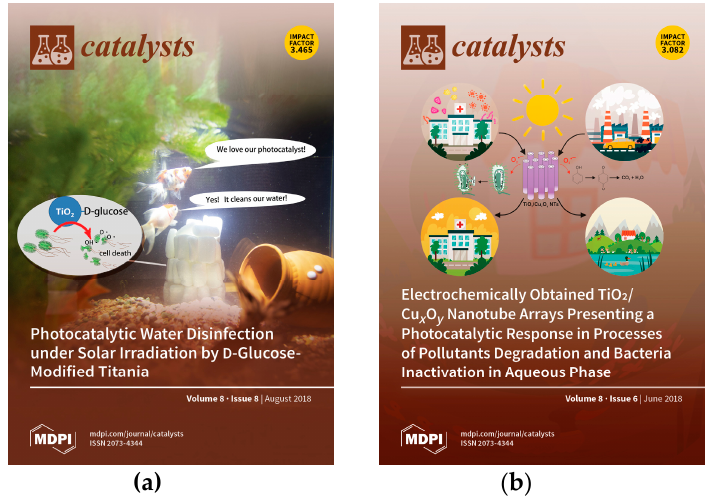
Figure 2. Journal covers of Catalysts showing possible applications of ( a ) modified titania with D-glucose for water tanks; volume 8, issue 8 (https://res.mdpi.com/data/covers/catalysts/big_cover- catalysts-v8-i8.png) [24] and ( b ) TiO 2 /Cu x O y nanotube arrays for environmental purification; volume 8, issue 6 (https://res.mdpi.com/data/covers/catalysts/big_cover-catalysts-v8-i6.png) [18].